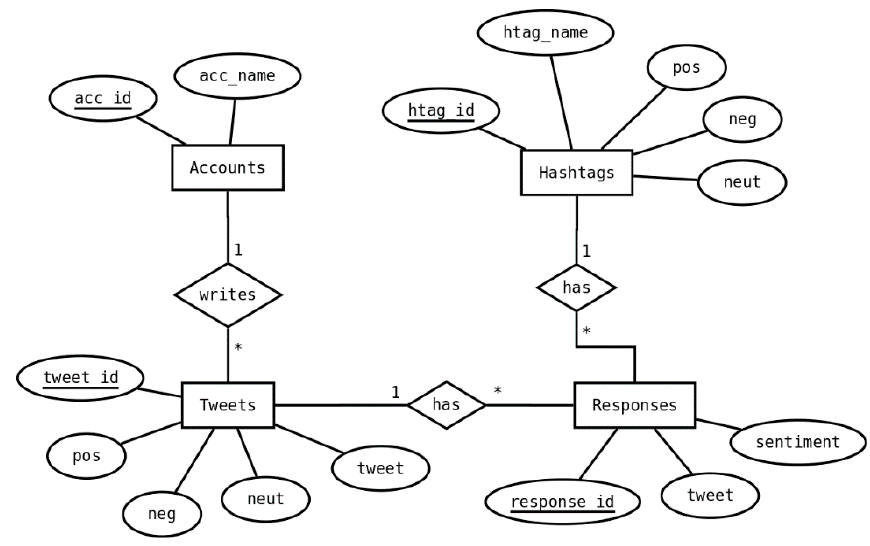
Figure 2. Database design.